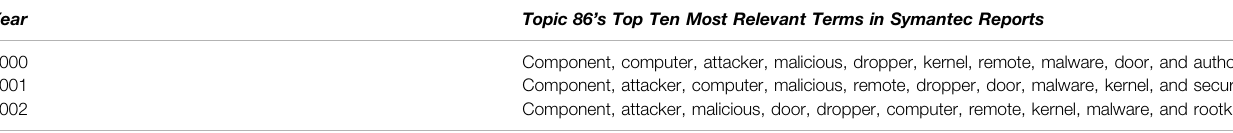
TABLE 7 | 100-topic Symantec Malware report of the dynamic topic model topic